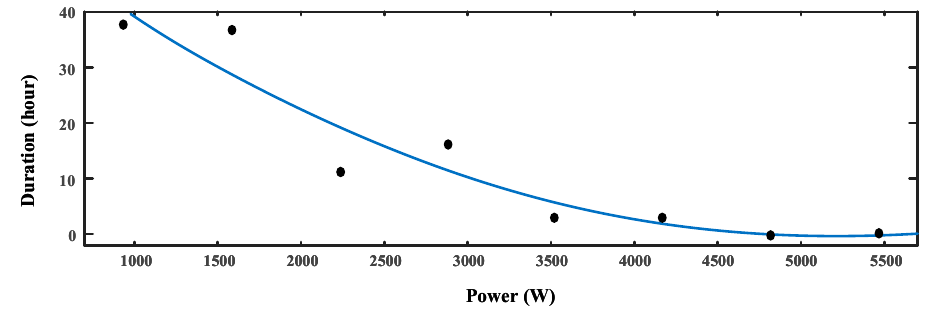
Figure 7. The heat demand distribution curve for the terraced house which was built approximately 30 years ago.